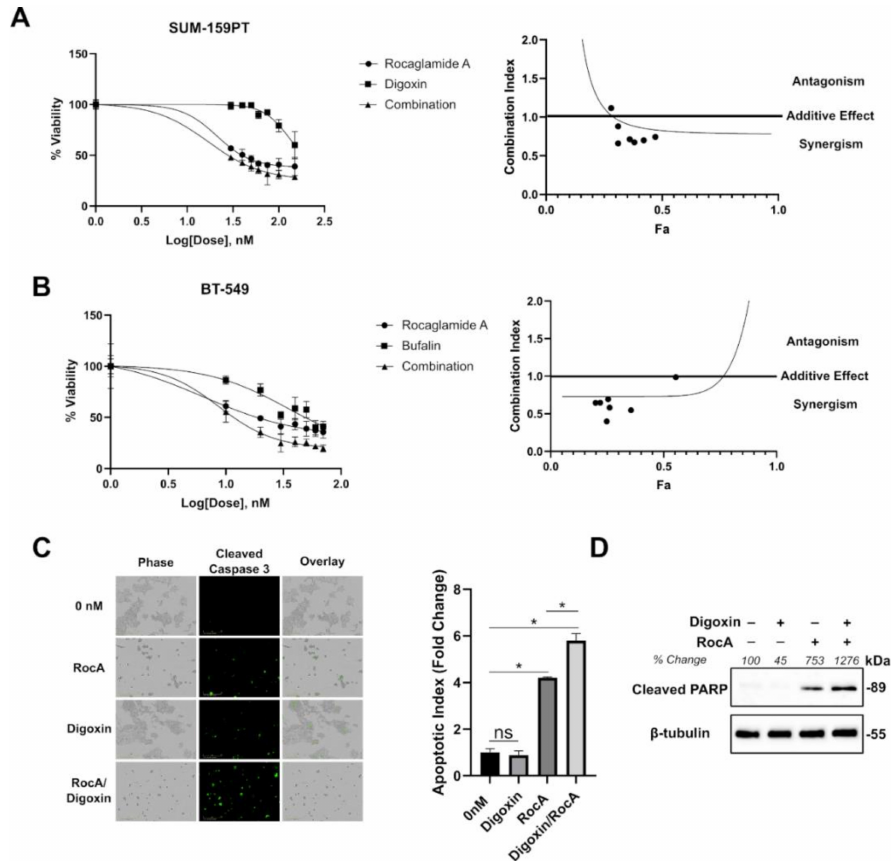
Figure 5. Rocaglates in combination with cardiac glycosides are synergistic in inhibiting TNBC cells in vitro. ( A ). Cell viability readings using Cell Titer GLO in SUM-159PT cells following the treatment of rocaglamide A, digoxin, or the combination of both (0–150 nM). ( B ). Cell viability readings using Cell Titer Blue in BT-549 cells following the treatment of rocaglamide A, bufalin, or the combination of both (0–70 nM). ( C ). Cleaved caspase 3 staining in SUM-159PT cells following treatment with rocaglamide A, digoxin, or the combination of both (50 nM) after 24 h. Apoptotic index was calculated based on the total green object integrated intensity normalized to the % confluence of each image (* indicates p < 0.05 as analyzed by a one-way ANOVA with Bonferroni post hoc test). ( D ). Western blots following treatment with 50 nM of digoxin, rocaglamide A, or the combination of both for 48 h in SUM-159PT cells. Band intensities were calculated by densitometry based on the ratio of cleaved poly ADP ribose polymerase (PARP) normalized to the β -tubulin protein signal with 0 nM set to 100. Uncropped blots are shown in Figure